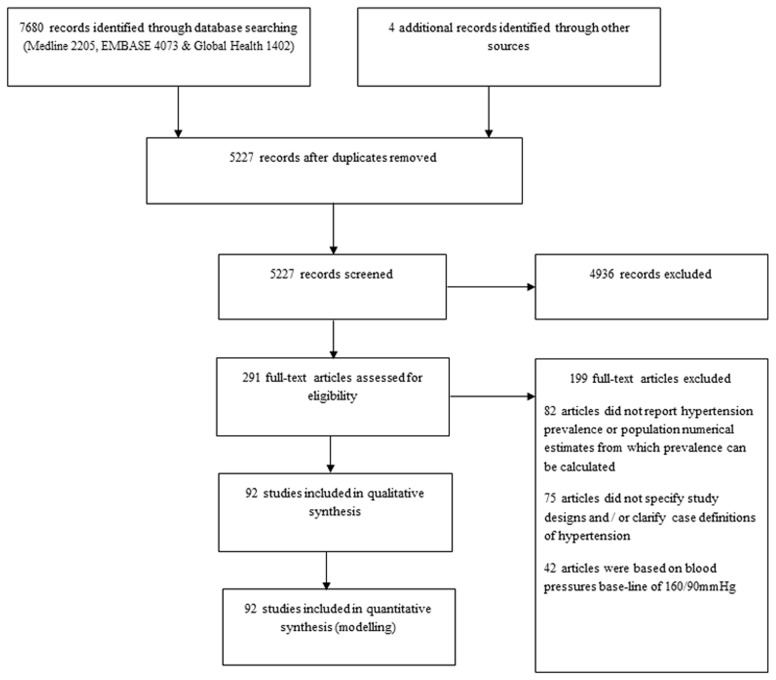
Flow diagram of search results.